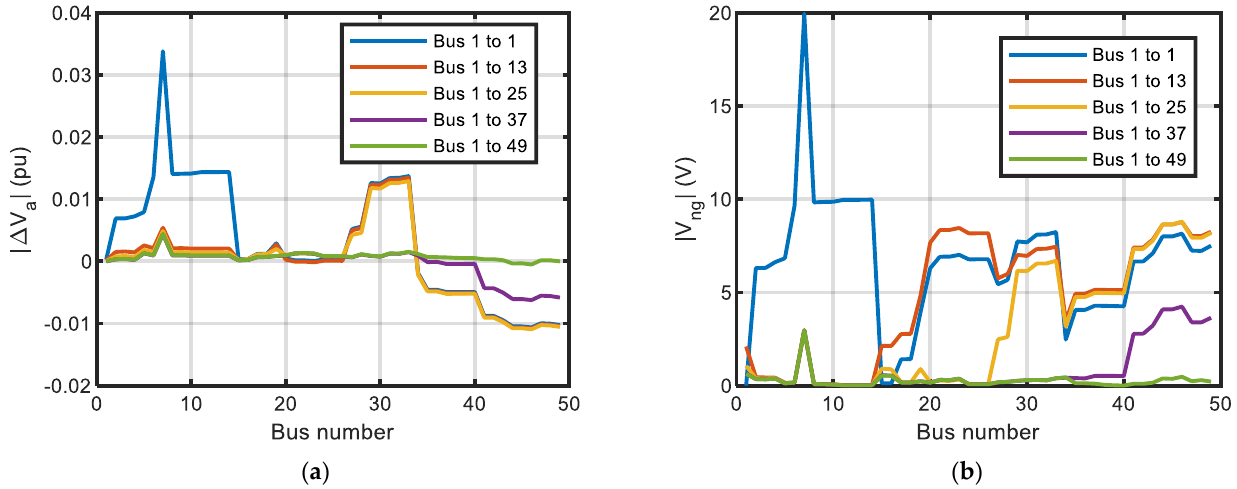
Figure 17. Phase voltage magnitude error between 3 CM and 4 CM of the 49-bus test feeder, with R k e = 0.1 Ω ( a ) and neutral-to-ground voltage of 49-bus test feeder for ( b ).